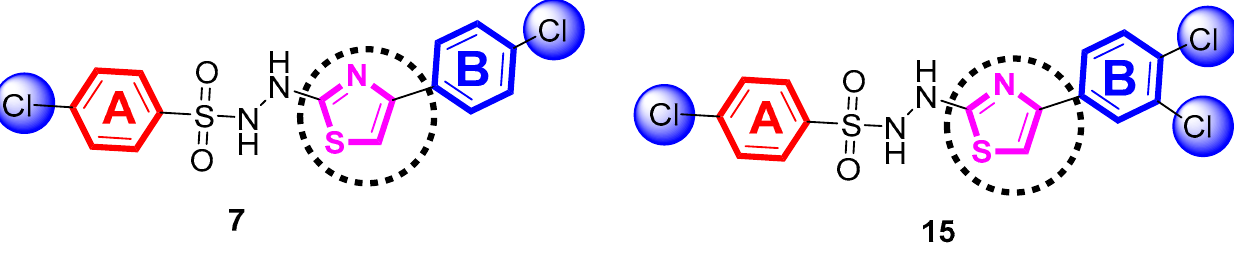
Figure 5. SAR study for scaffolds 7 and 15 .